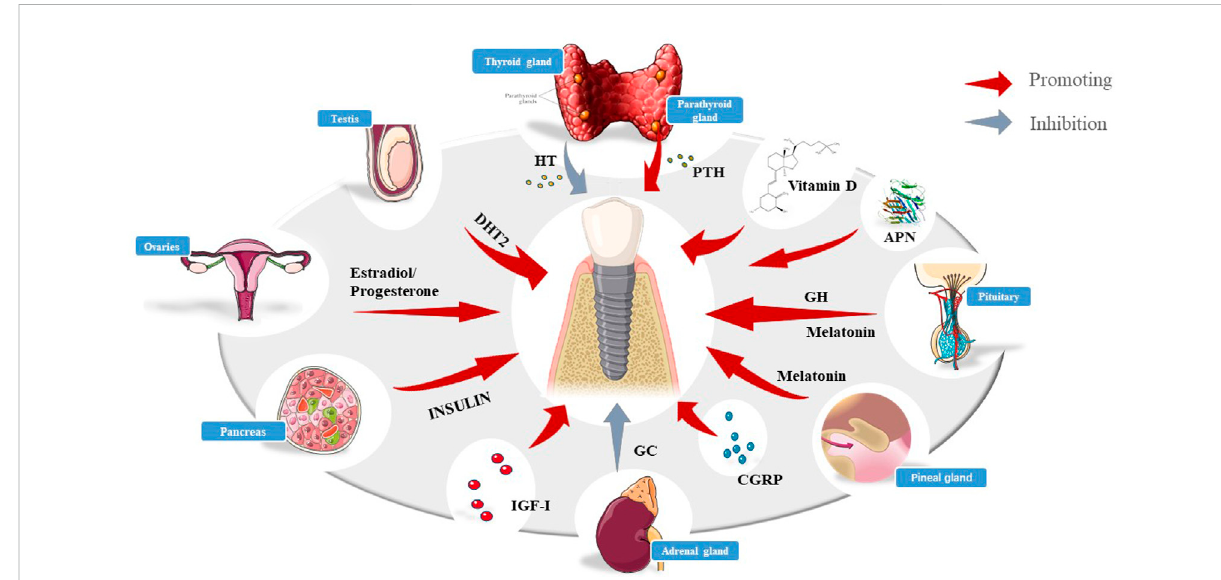
FIGURE 1 Schematic diagram of various hormones affecting implants, including insulin, HT, PTH, DHT2, melatonin, vitamin D, GC,IGF- Ⅰ ,and so